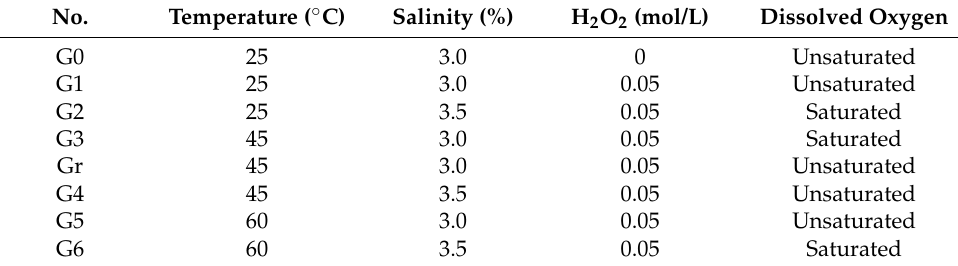
Table 2. The conditions of accelerated corrosion tests.